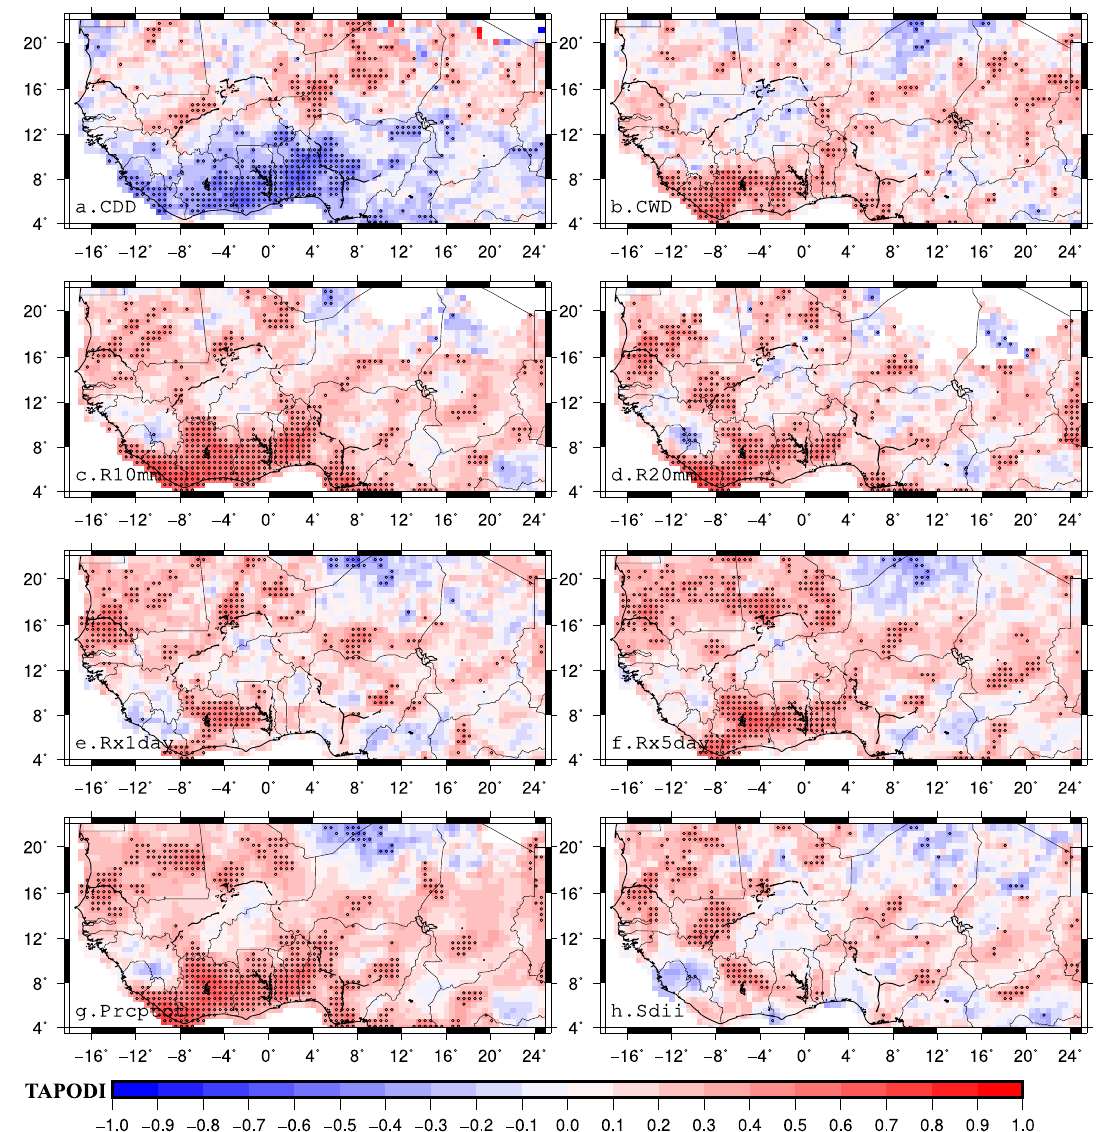
Figure 11. Correlation patterns between TAPODI and extreme precipitation indices. Tipping points represent significant correlation areas using EDOF. ( a ) CDD, ( b ) CWD, ( c ) R10mm, ( d ) R20mm, ( e ) Rx1day, ( f ) Rx5day, ( g ) Prcptot and ( h ) Sdii.